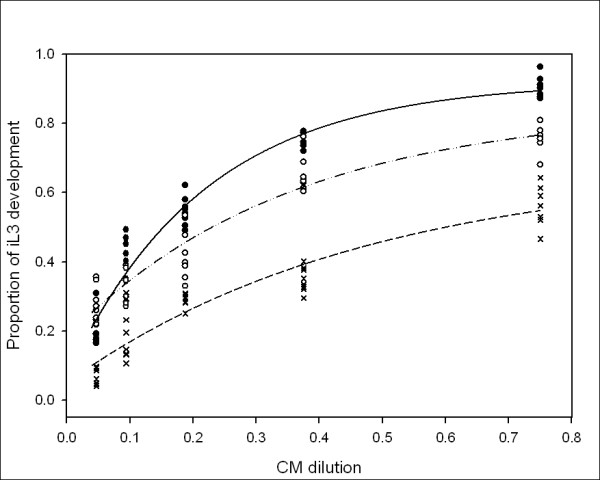
The effect of various incubation temperatures on the proportion of P. trichosuri iL3 development in response to conditioned medium concentration. P. trichosuri L1 larvae at one individual per microliter were incubated at either: 14°C, 20°C or 26.5°C with gentamicin sulfate at 50 μg/μL, and 0.35% HB101 as food source and serially diluted conditioned medium. Solid line and circle is 14°C, n = 5234; dashed line and open is 20°C, n = 7847; dotted line and cross is 26.5°C, n = 7937. On day 5, the proportion of larvae that had developed into iL3 was scored in six replicate wells. The lower the temperature in which the P. trichosuri were raised, the more likely they develop as infective larvae.